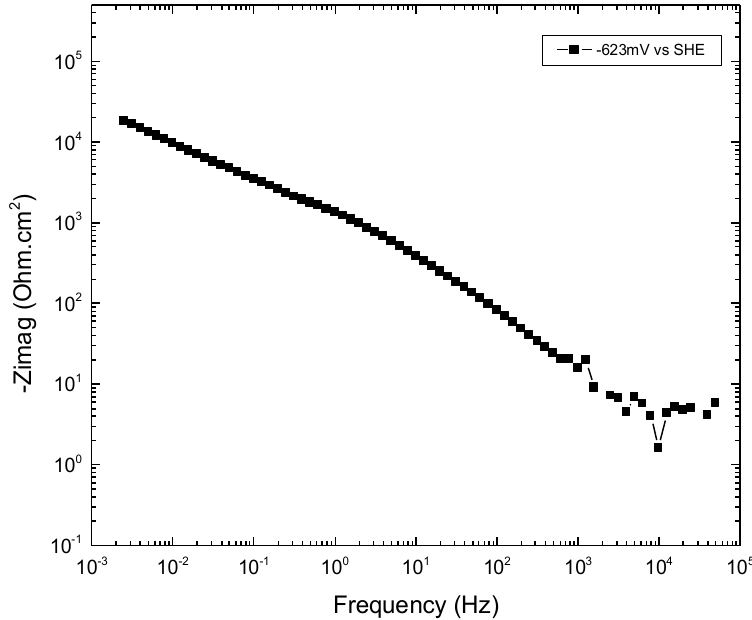
Figure A5. Plot of Log Im. vs. Log Frequency of Zn Test at − 623 mV. The following reasoning suggested that the transition in the dominant imaginary